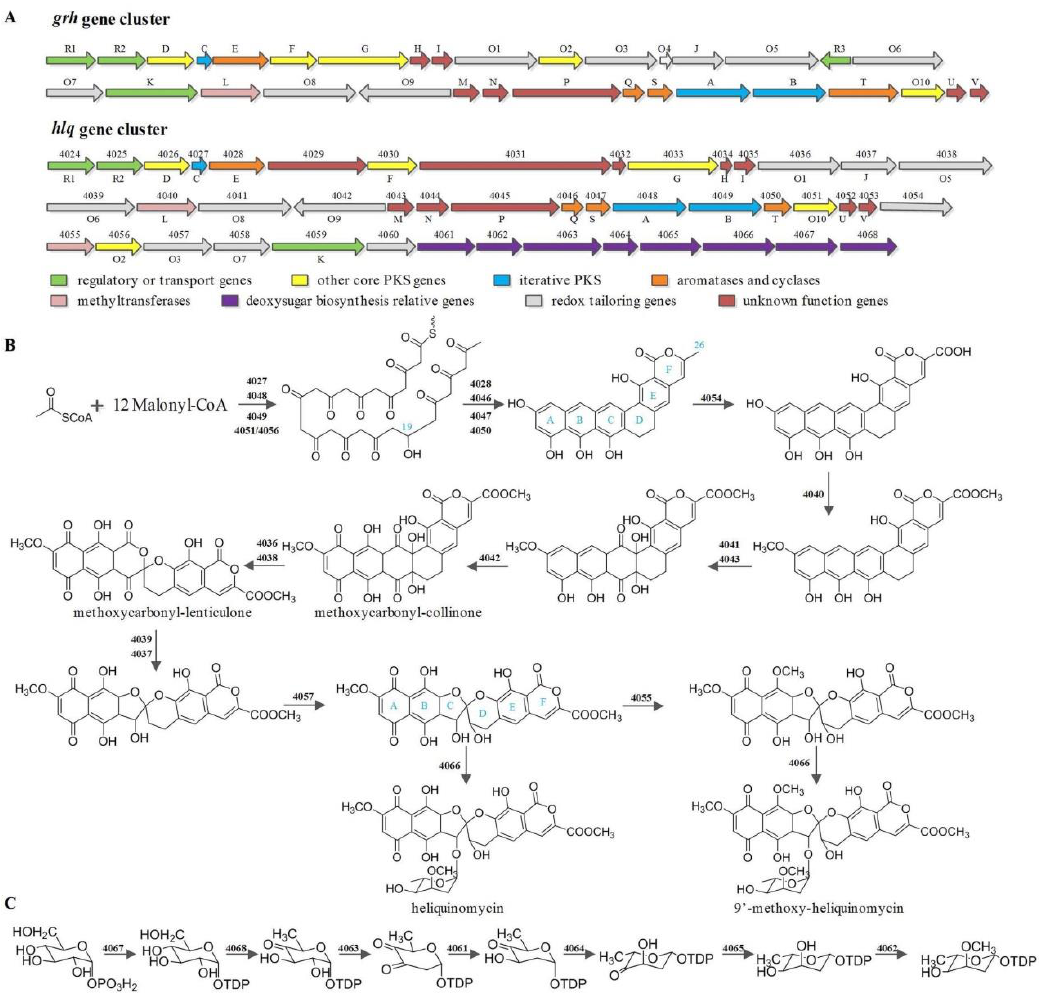
Figure 4. Identification of biosynthetic information of heliquinomycins. ( A ). Biosynthetic gene clusters of griseorhodin A ( grh ) and heliquinomycins ( hlq ). Individual genes are labeled by their numbers or names above the arrows. Genes of grh gene cluster which are homologous to those of hlq are exhibited under the arrows. ( B ). Proposed biosynthesis of the heliquinomycins. ( C ). Proposed biosynthesis of the 2,6-dideoxy-3- O -methylhexopyranose sugar moiety of heliquinomycins.